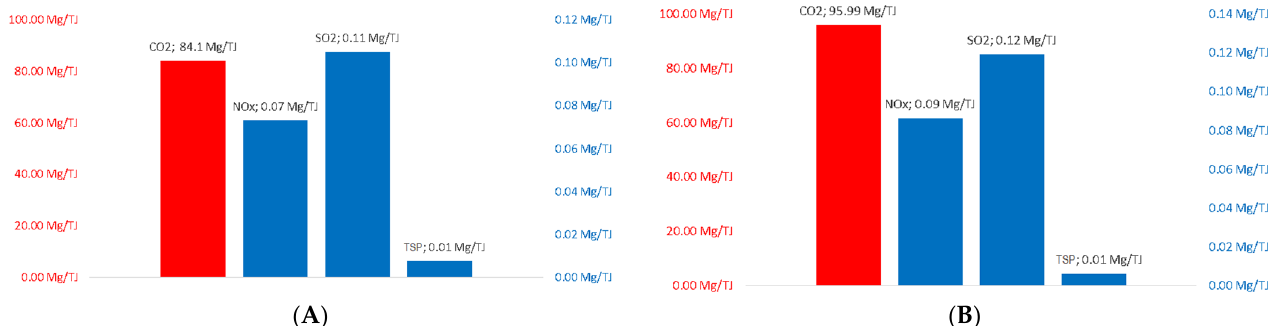
Figure 3. Simulation of results of Hubgrade application in the whole GZM and Warsaw district heating systems.